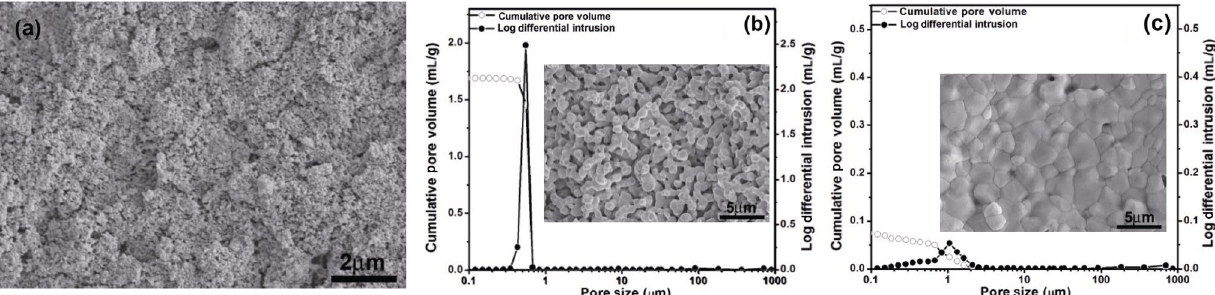
Fig. 4 (a) SEM image of the gel cast green bodies with 48 wt% HA. MIP and SEM image (inserted in MIP) of the HA ceramics prepared (b) from the gel cast green bodies with 48 wt% HA or (c) from the green bodies only containing HA powders and HPMC (above ceramics were sintered at 1100 ℃ for 6